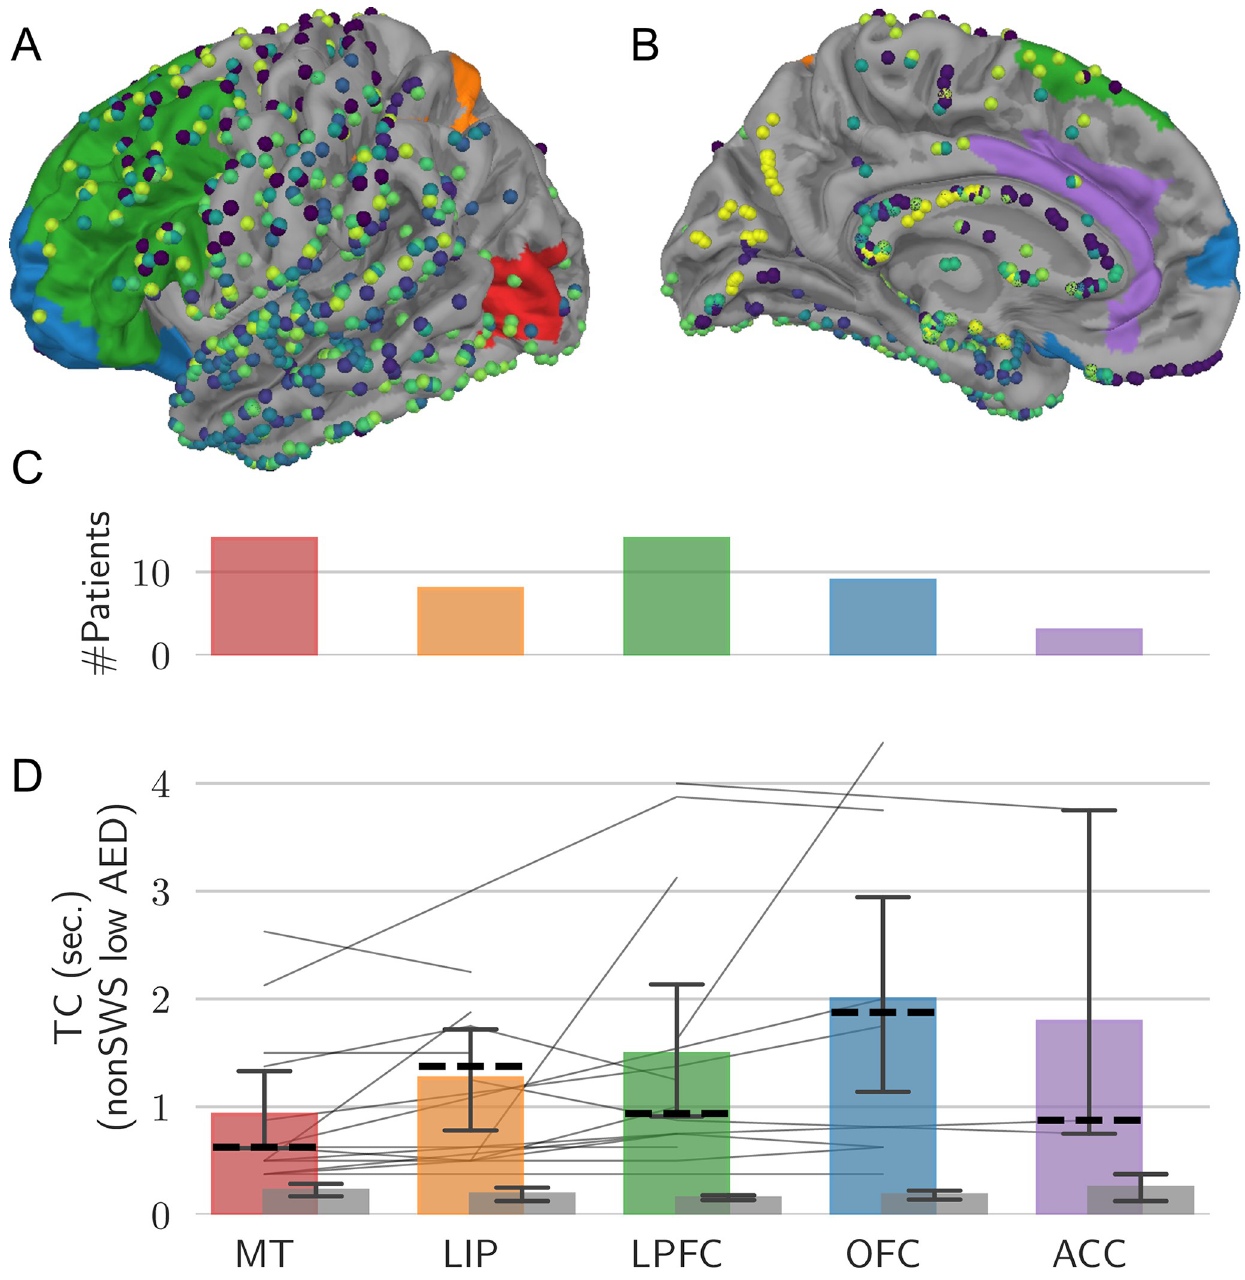
Fig 3. Temporal correlations increase with functional hierarchy. A, B Lateral and medial view of the left-hemisphere of a reference brain with electrodes of all patients projected onto the surface with coloured areas similar to [6]. C, D Number of electrodes and TC for each region. Thin lines indicate data from individual patients, coloured bars averages and dashed lines median values across patients. Whiskers denote the 95% confidence interval.